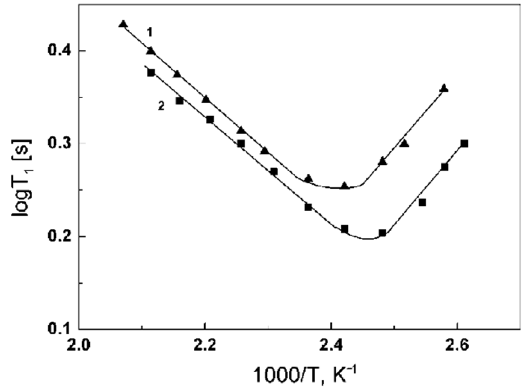
Figure 44. Temperature dependences of the 31 P nuclei spin -lattice relaxation times T 1 on (1) composite material Cs 2 (HSO 4 )(H 2 PO 4 )-CsH 2 PO 4 = 2:1 and (2) α-Cs 3 (HSO 4 ) 2 (H 2 PO 4 )-Cs 2 (HSO 4 )(H 2 PO 4 ) = 1:1. Reprinted with permission Ref. [89]. Copyright © 2022 Springer-Verlag Wien.